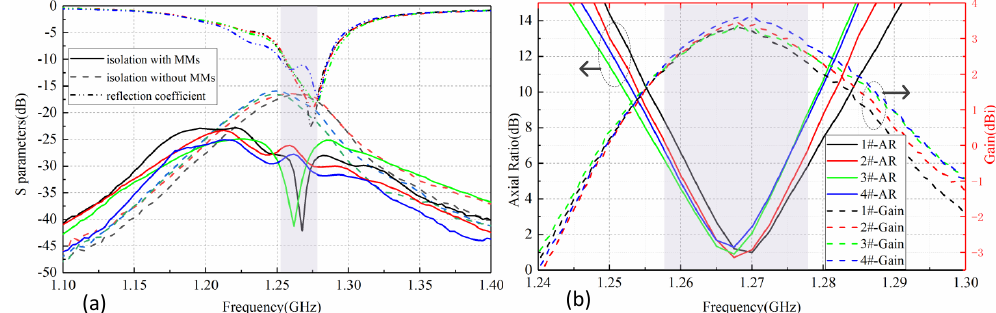
Figure 7. The measured ( a ) S parameters, ( b ) Axial ratio and gain of each BDS antenna with magnetic metamaterials.